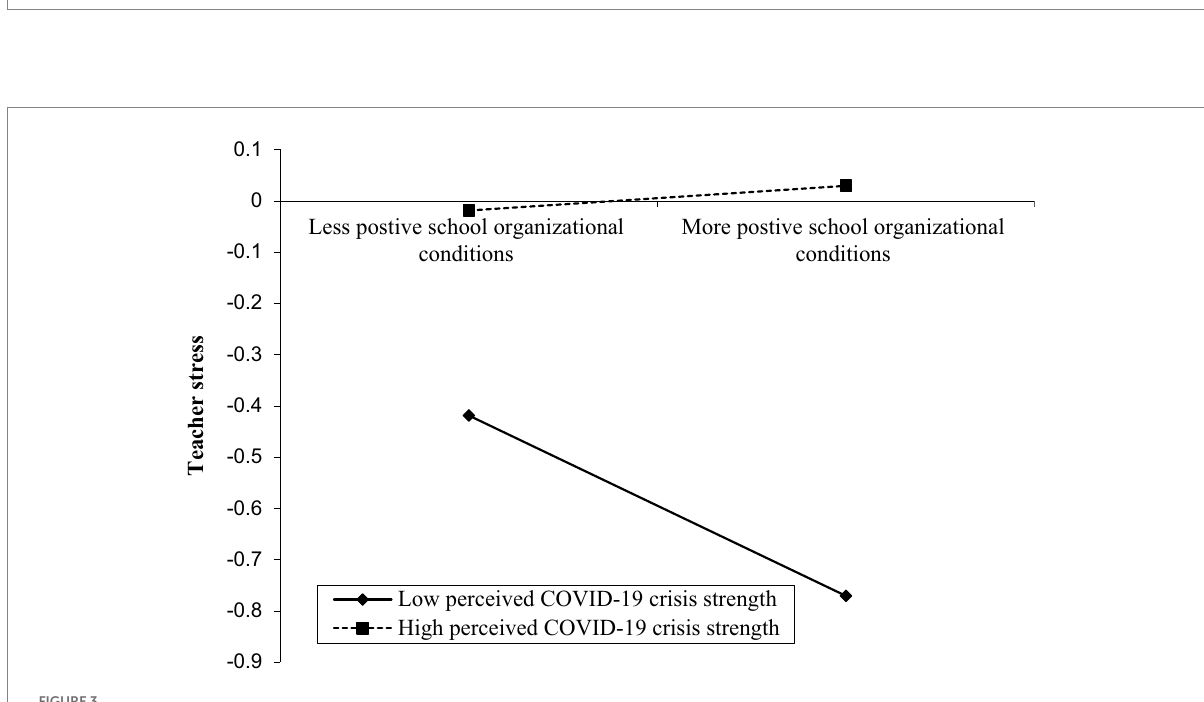
-0.9-0.8 FIGURE 3 Perceived COVID-19 crisis strength moderates the direct relationship between school organizational conditions and teacher